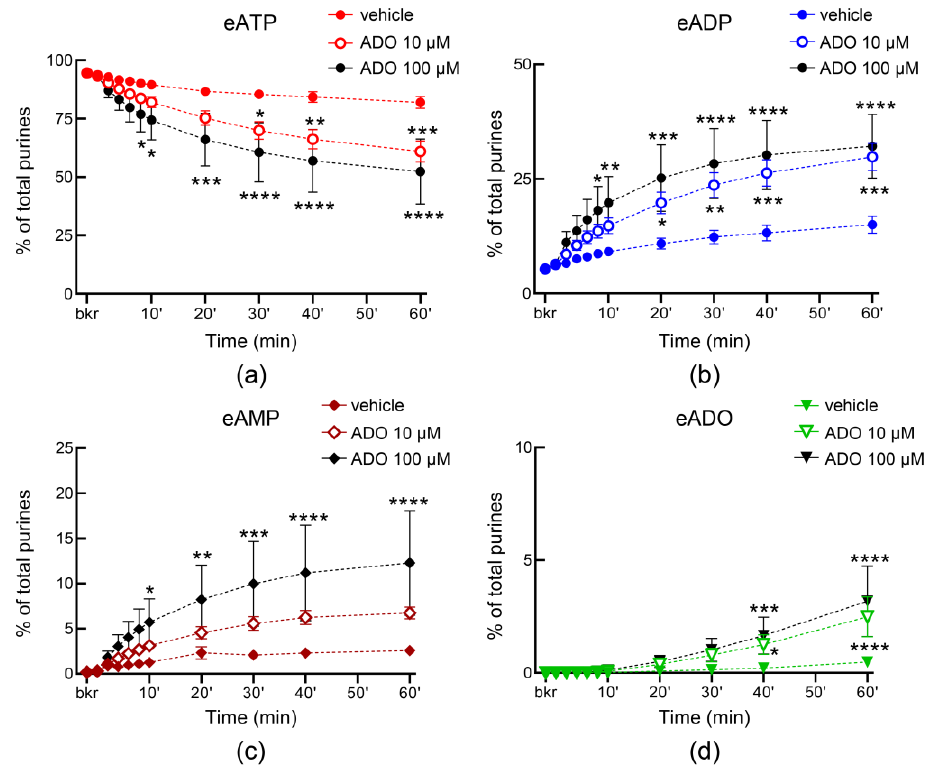
Figure 13. Effects of adenosine (ADO) on the release of soluble nucleotidases in lamina propria of nondistended denuded bladder preparations. Time courses of eATP decrease ( a ), eADP increase ( b ), eAMP increase ( c ), and eADO increase ( d ) after addition of eATP to ELS collected from nondistended bladder preparations treated with either vehicle (KBS, n = 9) or ADO ( n = 4 each) for a time period equivalent to the time for bladder filling; n , number of bladder preparations. Note that the degradation of eATP was enhanced in concentrated ELS collected from preparations treated with ADO. * p < 0.05, ** p < 0.01, *** p < 0.001, **** p < 0.0001 vs. vehicle controls. 2 way ANOVA with Tukey’s multiple comparisons tests.